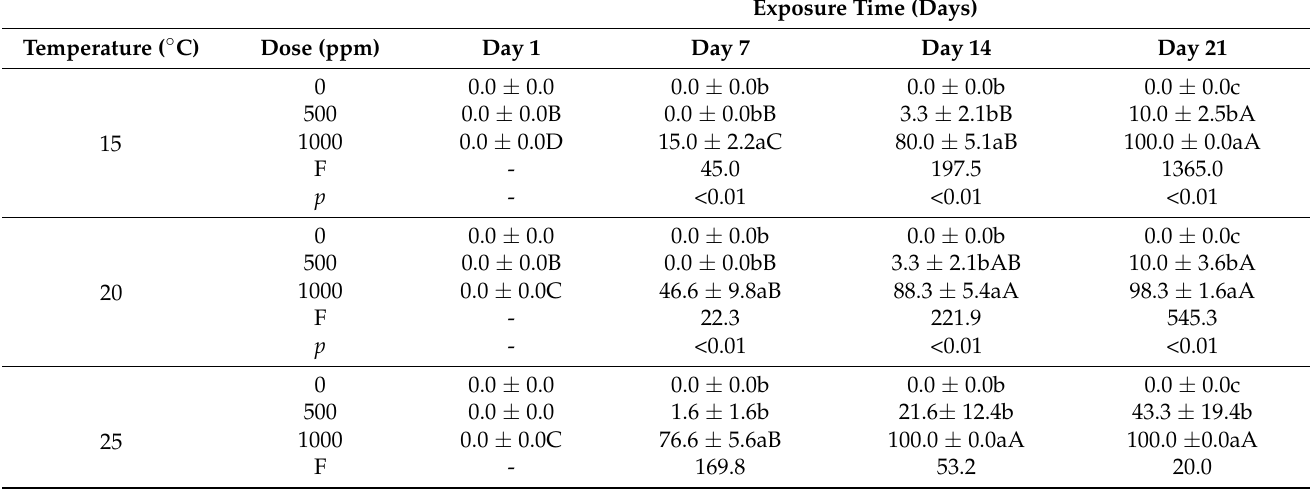
Table 6. Mean mortality (% ± SE) of T. confusum adults exposed for 1, 7, 14, and 21 days to wheat treated with three different doses of diatomaceous earth (0, 500, and 1000 ppm) and four different temperatures (15, 20, 25, and 30 ◦ C), at 55%